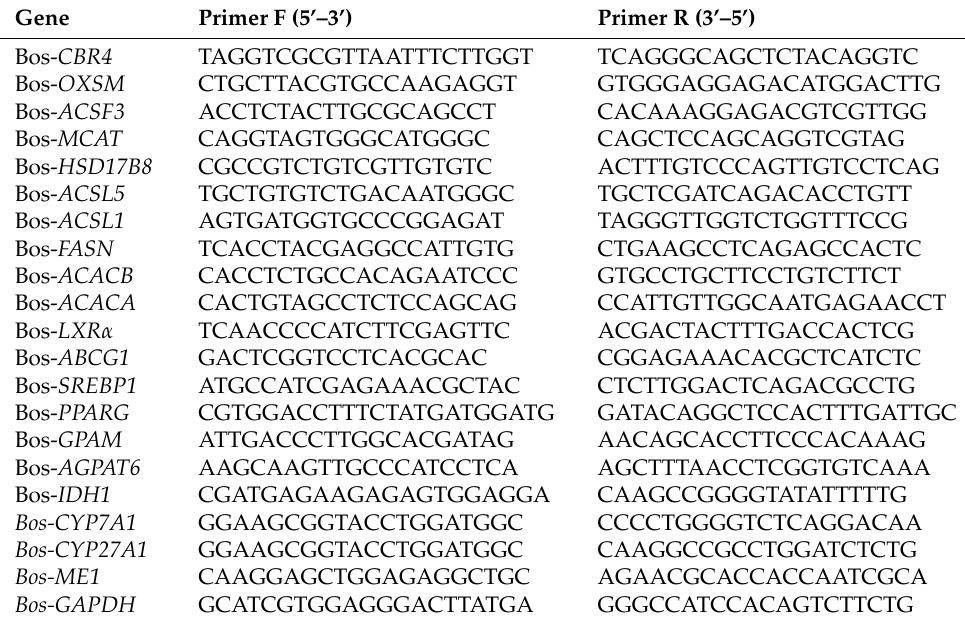
Table 4. Real-time PCR primer sequences of PPARG and PPARA pathway related, and other marker genes of lipid